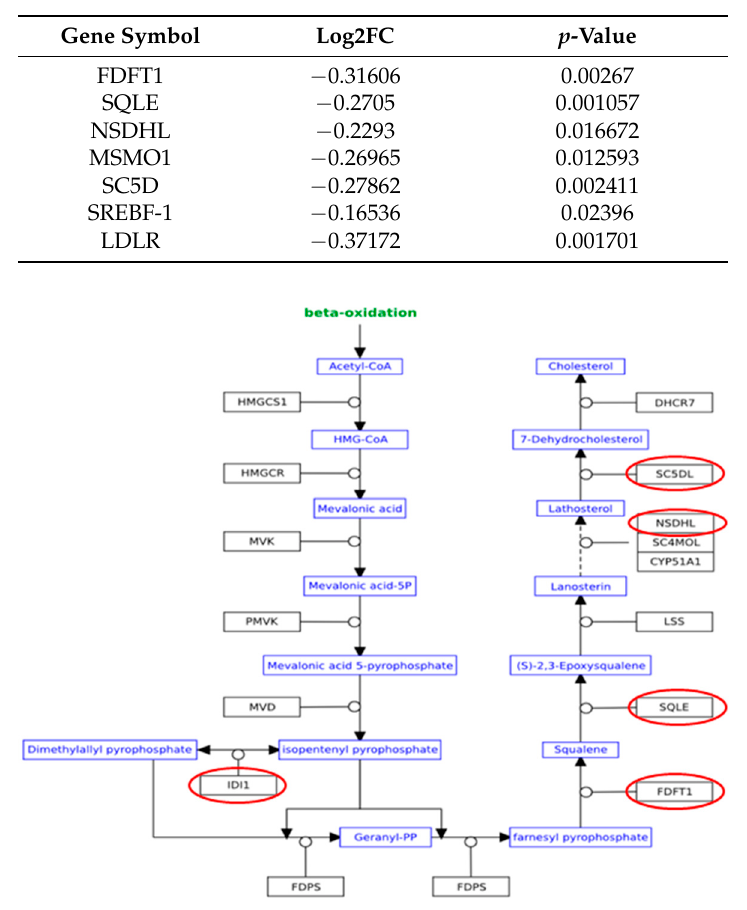
Table 4. Gene expression values of cholesterol related genes.